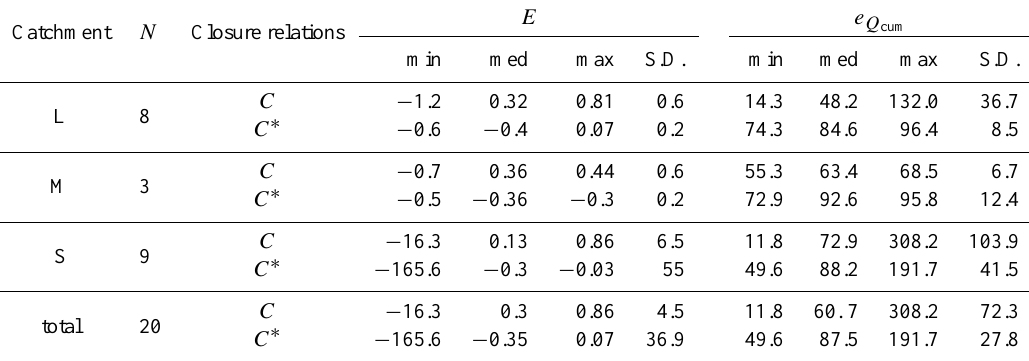
Table 11. Performance of C and C ∗ after calibration. Catchment N Closure relations